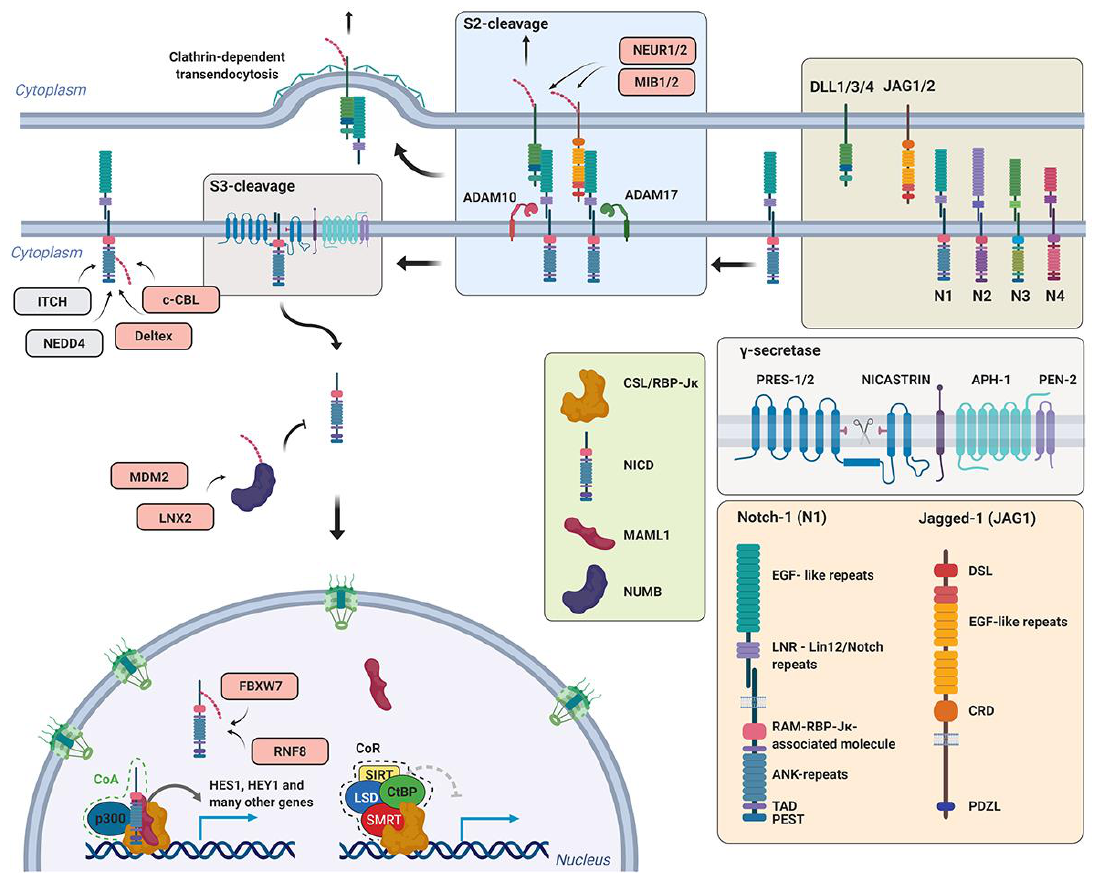
Figure 5. Notch signaling pathway by ubiqutination upon binding of Jagged/Delta (JAG/DLL) ligands to the Notch receptor (N1); the endocytic system is activated in the ligand-bearing cell. This leads to two sequential proteolytic events. The first is metalloproteinase-dependent (ADAM10/17) and it releases the extracellular domain of the Notch receptor which is afterward engulfed via transendocytosis. The second proteolytic cleavage is membrane bound and dependent on γ -secretase activity. After this step, NICD (the Notch intracellular part) is released to the cytosol and transported to the nucleus where it interacts with the CSL/RBP- Jκ transcription factor and its co -factor Mastermind (MAML1). The complex is tethered to promoters of Notch target genes. For details see the